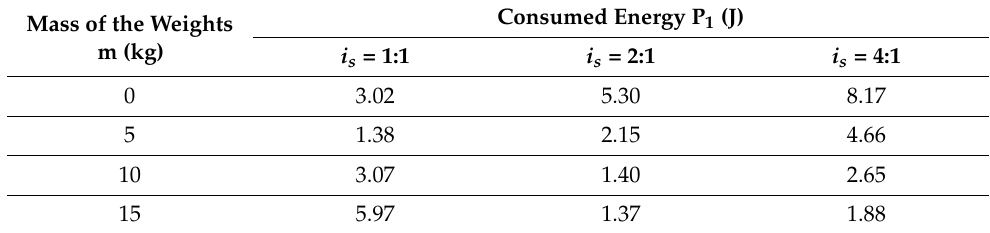
Table 2. Values of the energy E 1 consumed during reconstruction of a sinusoidal motion profile. Mass of the